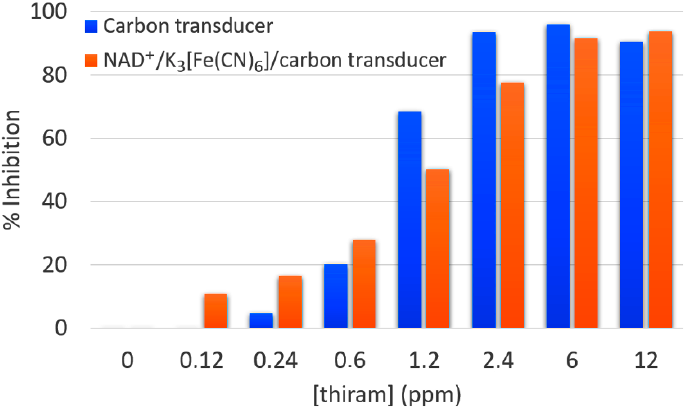
Figure 4. Detection of thiram at +0.40 V after the incubation of the enzymatic system with various concentrations of thiram and 0.24 U/mL ALDH, 0.24 U/mL DP, 1 mM NAD + , 1 mM K 3 [Fe(CN) 6 ], 2 mM PPA and 0.1% BSA in 0.1 M phosphate + 0.1 M KCl buffer solution pH 8.0 with DRP-110 carbon transducer (blue columns). Detection of thiram with the transducer DRP-110 modified with 6 mM NAD + and 6 mM K 3 [Fe(CN) 6 ] in 0.58 U/mL ALDH, 0.58 U/mL DP and 2 mM PPA in 0.1 M phosphate + 0.1 M KCl buffer solution pH 8.0 (orange columns).